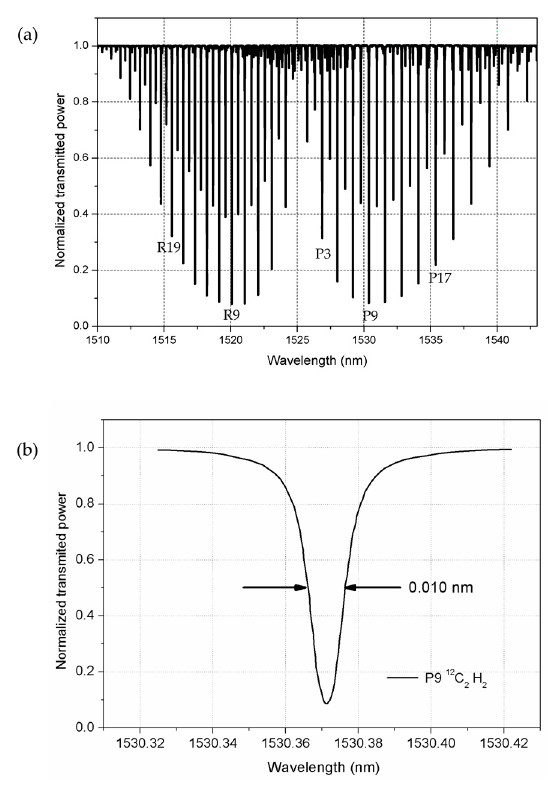
Figure 4. ( a ) Acetylene absorption spectrum; and ( b ) the detailed spectrum of its line P9.